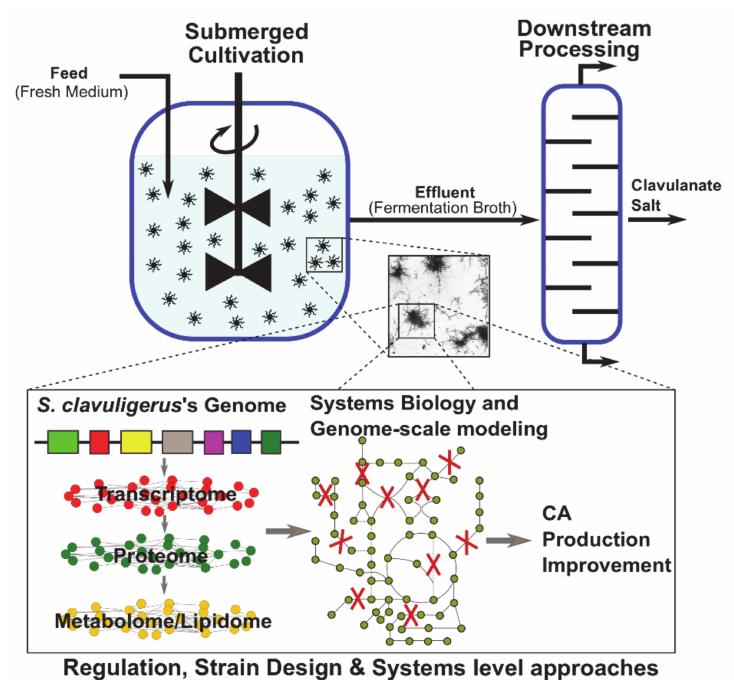
Figure 2. Holistic overview of the CA production